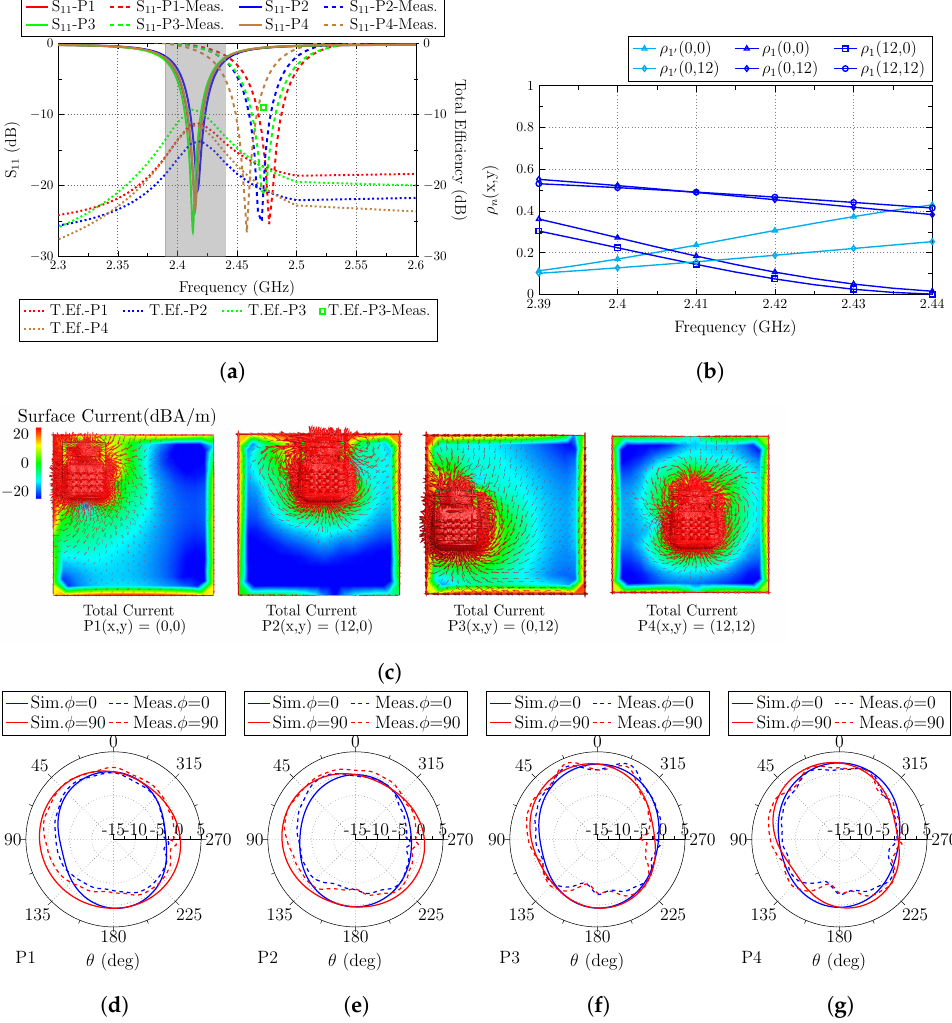
Figure 7. ( a ) Reflection coefficient (S 11 ) and total efficiency (dB) of the antenna located at the four analyzed positions (the frequency band colored in gray corresponds to the operating band analyzed with the correlation), ( b ) correlation (detailed in Equation (3)) of total and modal fields, ( c ) total current distribution of the antenna at the four positions, and radiation patterns at resonance when the antenna is placed at ( d ) P1(x,y) = (0,0), ( e ) P2(x,y) = (12,0), ( f ) P3(x,y) = (0,12), and ( g ) P4(x,y) =